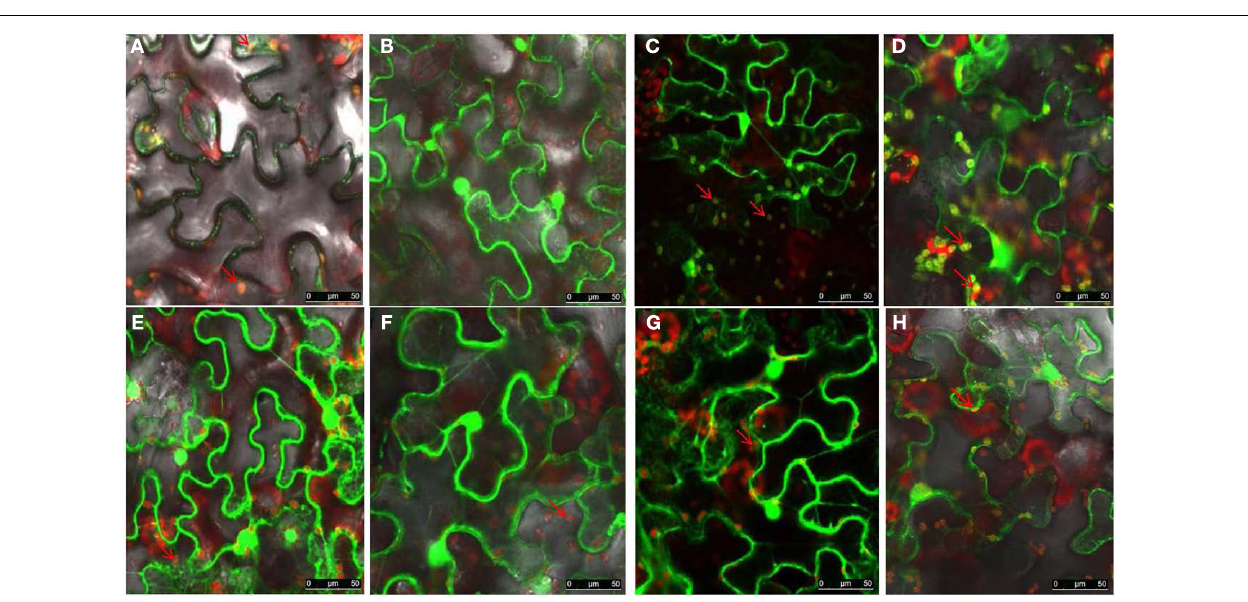
FIGURE 7 |The N-terminus 73 amino acids determine the chloroplast localization of NSvc4. N. benthamiana leaves were agroinfiltrated with pCHF3-NSvc4-eGFP (A) , pCHF3-NSvc4 1–54 -eGFP (B) , pCHF3-NSvc4 1–73 -eGFP (C) , pCHF3-NSvc4 1–125 -eGFP (D) , pCHF3-NSvc4 54–73 -eGFP (E) , pCHF3-NSvc4 125–286 -eGFP (F) , pCHF3-NSvc4 106–125 -eGFP (G) ,